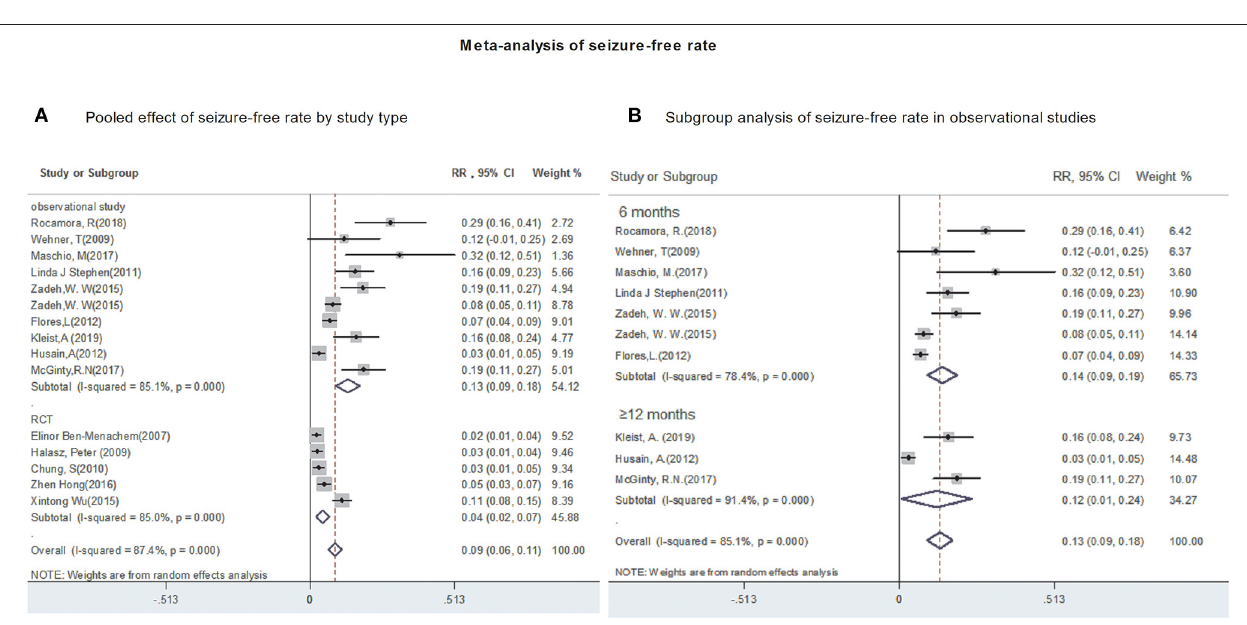
seizure control. Our findings are similar to those of